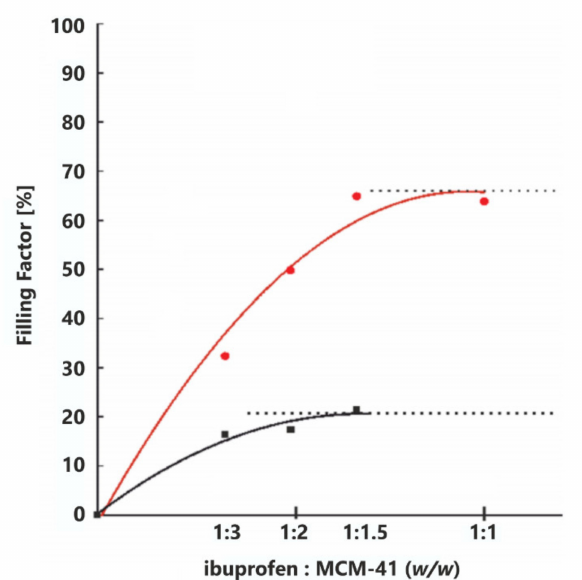
Figure 11. Comparison of the filling factors for the incipient wetness impregnation (black squares) and melting (red circles) methods. Values on the horizontal axes represent the weight ratio of ibuprofen: MCM-41 used for impregnation and melting. Adapted with permission from [83], Copyright 2014 American Chemical